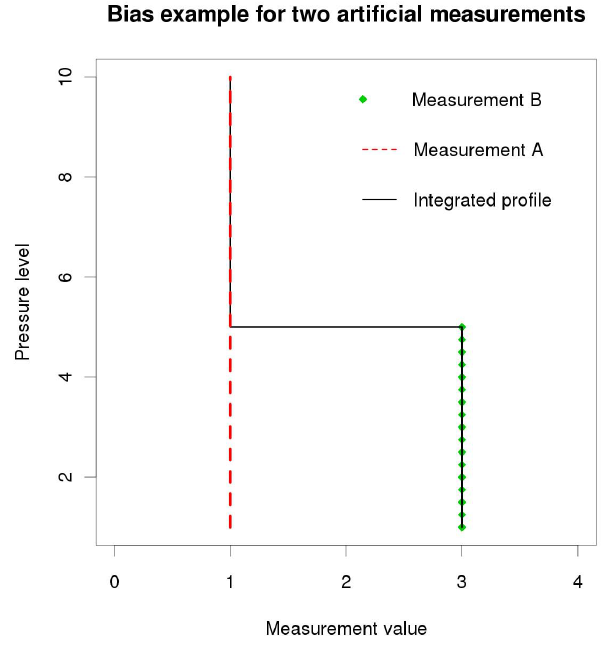
Fig. 9. Illustration of the bias introduced by the extrapolation of measurement B to a total column using data of measurement A . The integrated profile leads to a calibration value of 2, while the true value should be 3.